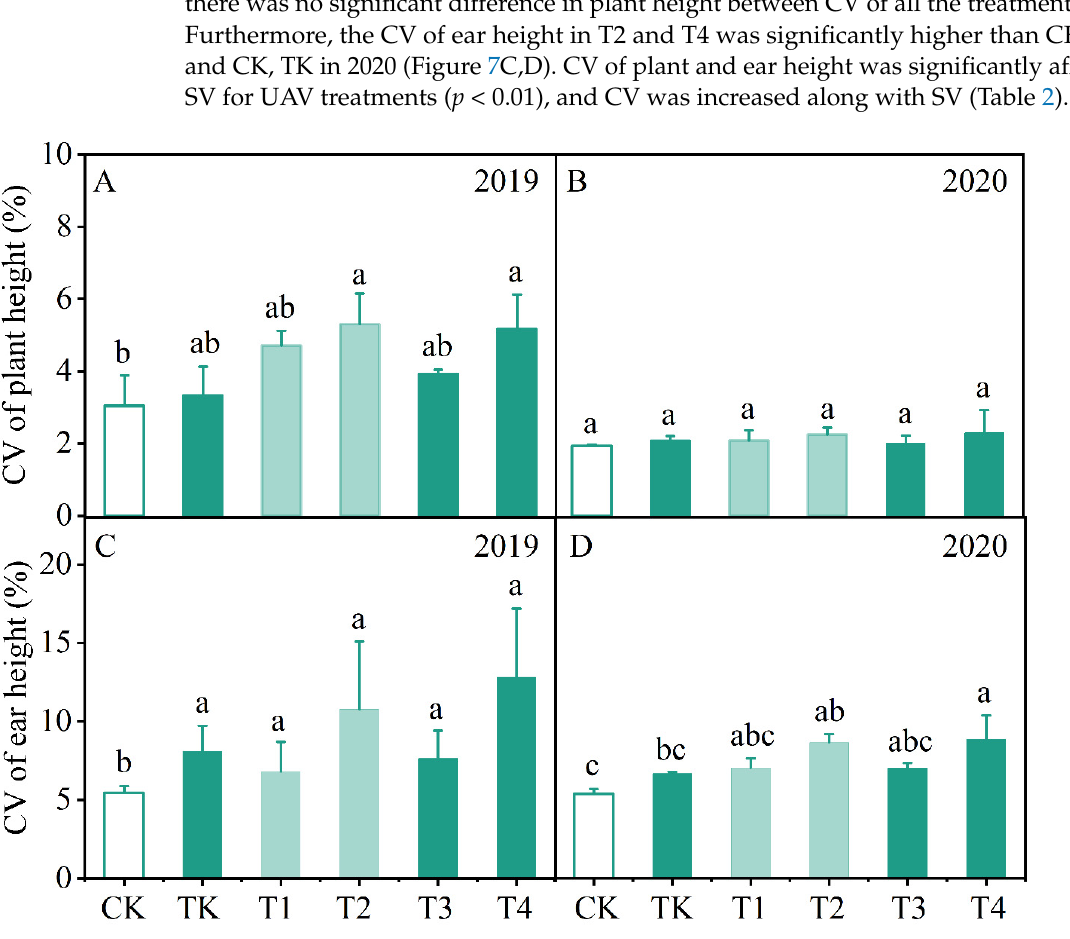
Figure 7. Coefficient of variation of plant and ear height in 2019 and 2020. CV of plant height in 2019 ( A ) and 2020 ( B ). CV of ear height in 2019 ( C ) and 2020 ( D ). The same color in a column represents the same dosage of EDAH. One-way ANOVA followed by Tukey test was used, and different letters above the bars indicated the significant differences ( p < 0.05) among treatments. Bars are the standard deviation of three replications.